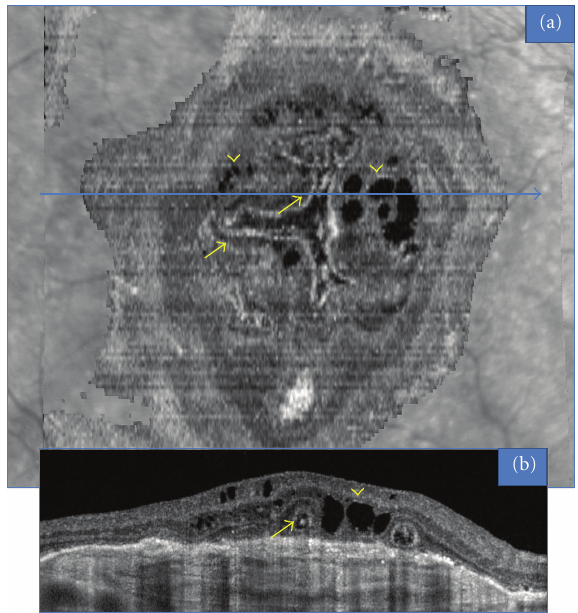
Figure 3: ORT (arrows) associated with intraretinal cystoid cavities (arrow heads) in the case of a fibro-vascular scar, observed with “en face” OCT (a). Corresponding B-scan OCT